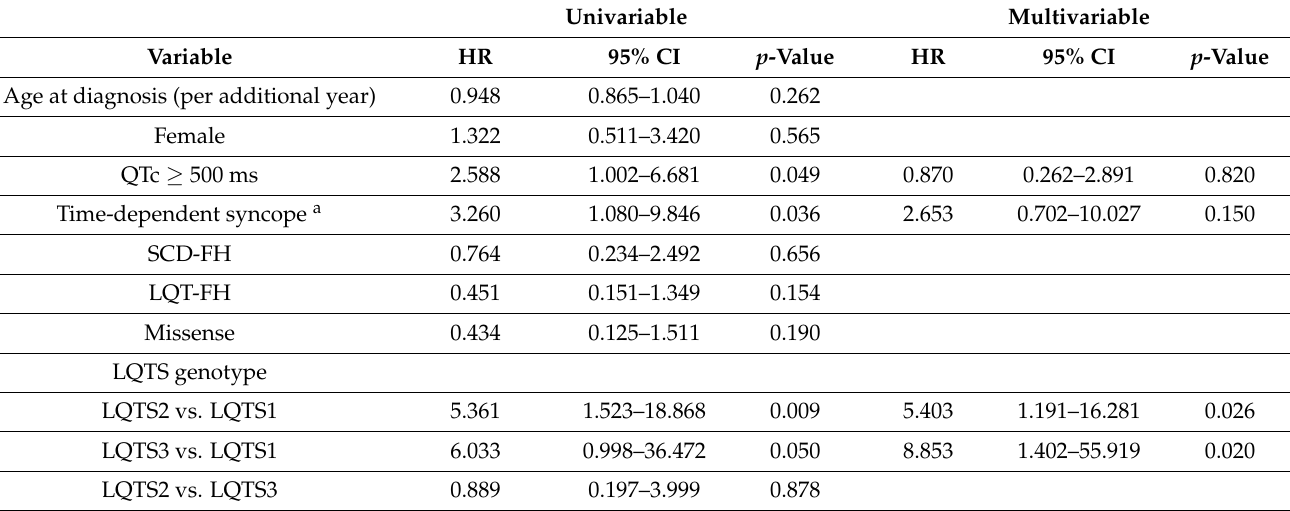
Table 3. Cox regression model: risk factors for